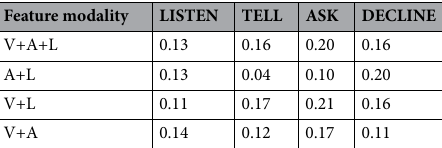
2 Table 6. R of ablation study on modalities.